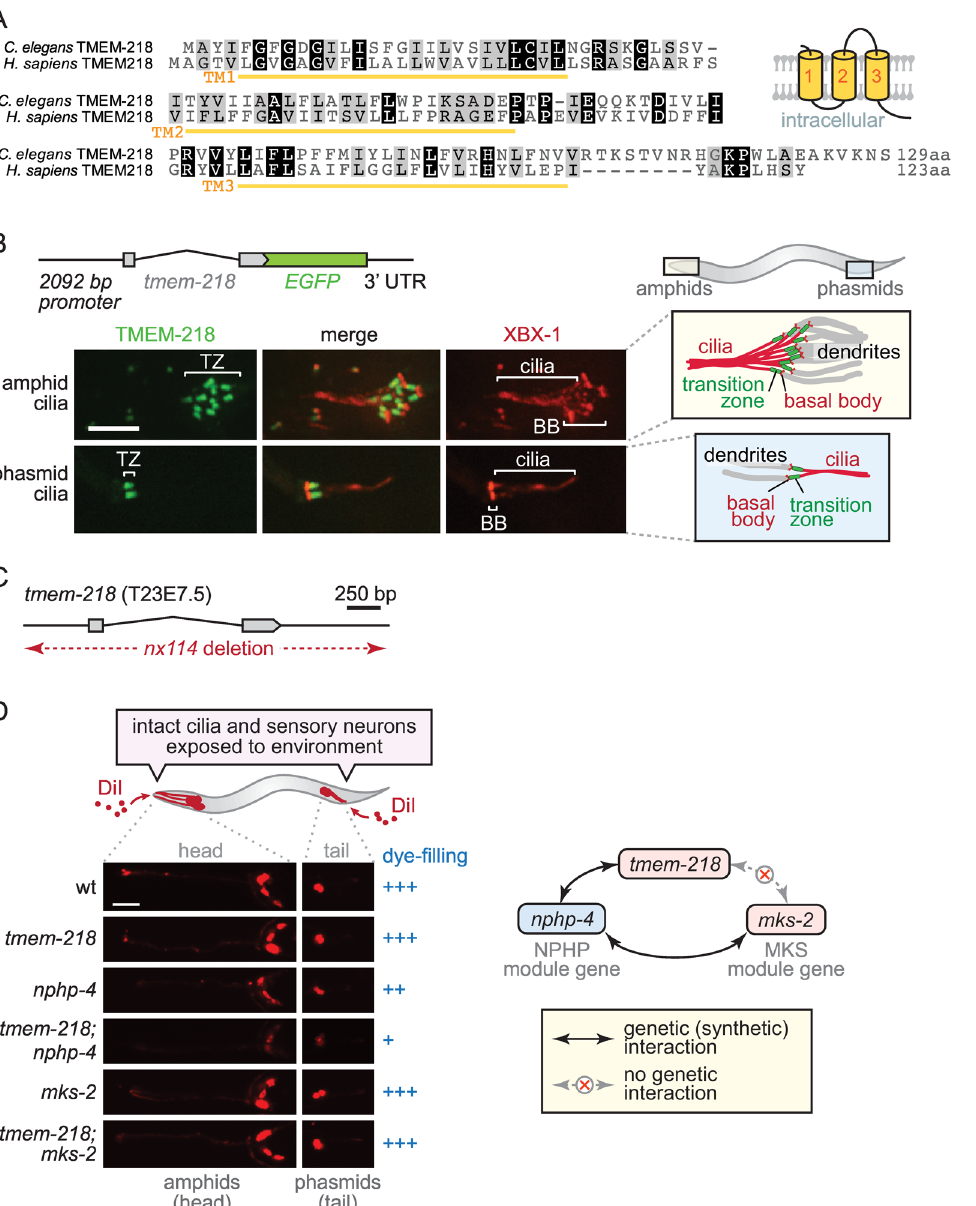
Fig 1. C . elegans tmem-218 encodes a novel transition zone protein and genetically interacts with nphp-4 but not mks-2 , consistent with it being part of the Meckel syndrome (MKS) module. ( A ) Amino acid sequence alignment of C . elegans TMEM-218 and its Homo sapiens orthologue. Both proteins are predicted to encode proteins with three transmembrane domains (TM1-3), with the predicted topology shown schematically. ( B ) C . elegans tmem-218 (T23E7.5) is expressed specifically in ciliated sensory neurons and its encoded product (TMEM-218) tagged with green fluorescent protein (GFP; green) localises to the ciliary transition zone (TZ) at amphid (head) and phasmid (tail) cilia found at the distal ends of dendrites. The tdTomato-tagged intraflagellar transport (IFT) protein XBX-1 (red) marks basal bodies (BB) and ciliary axonemes. Scale bar, 4 μ m. ( C ) The tmem-218(nx114) mutant allele used in this study, generated using transposon-mediated mutagenesis, represents a complete and specific deletion of the tmem-218 gene. ( D ) Dye-filling assay schematic shows the fluorescent dye DiI (red) penetrating sensory neurons via structurally intact, environmentally exposed ciliated endings. Dye-filling of the tmem-218 and nphp-4 strains is normal (+++) or slightly reduced (++), respectively, whereas dye-filling of the tmem-218;nphp-4 double mutant is mostly disrupted (+). A lack of genetic (synthetic) interaction between tmem-218 and mks-2 is also consistent with TMEM-218 belonging to the MKS module (as depicted schematically). Scale bar, 40 μ